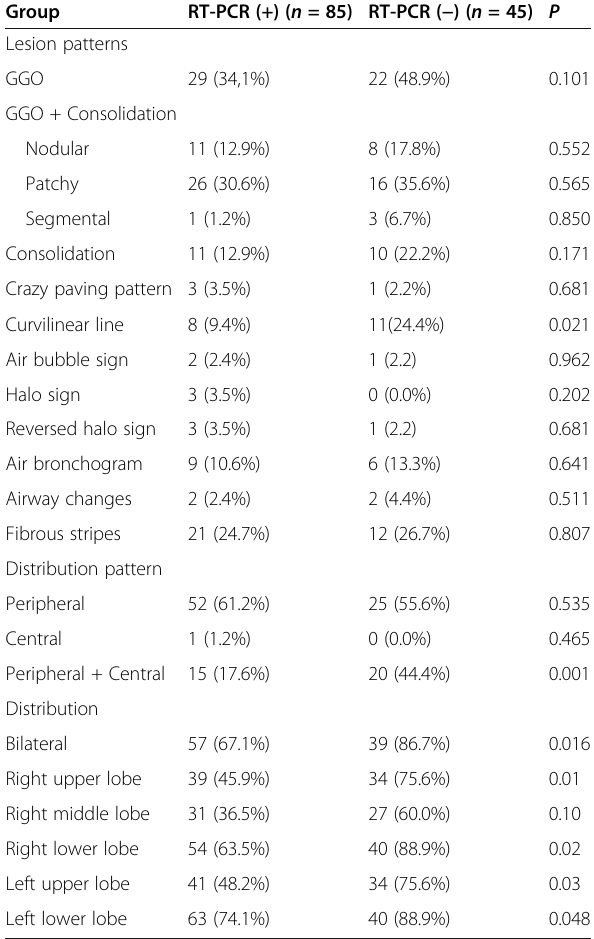
Table 1 CT imaging findings of patients (GGO; ground glass opacity, RT-PCR; reverse transcription polymerase chain reaction)